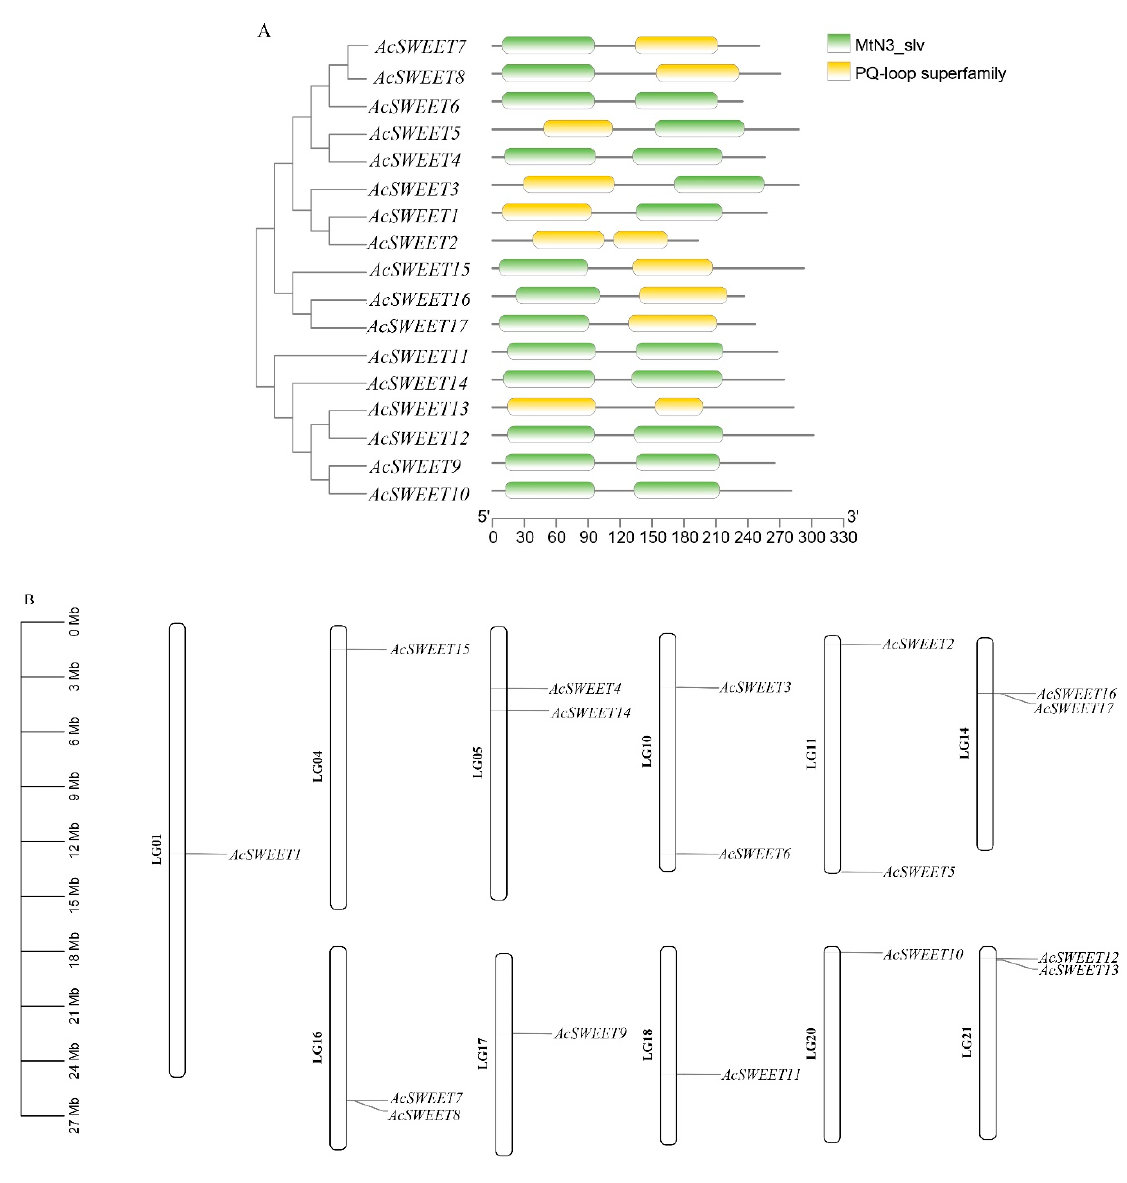
Figure 1. Conserved domain analysis of AcSWEETs and chromosomal location. ( A ) Different domains are represented in different colors along with the conservative domain of prediction as shown in the legend. ( B ) Location of AcC5-MTase genes on the chromosomes.